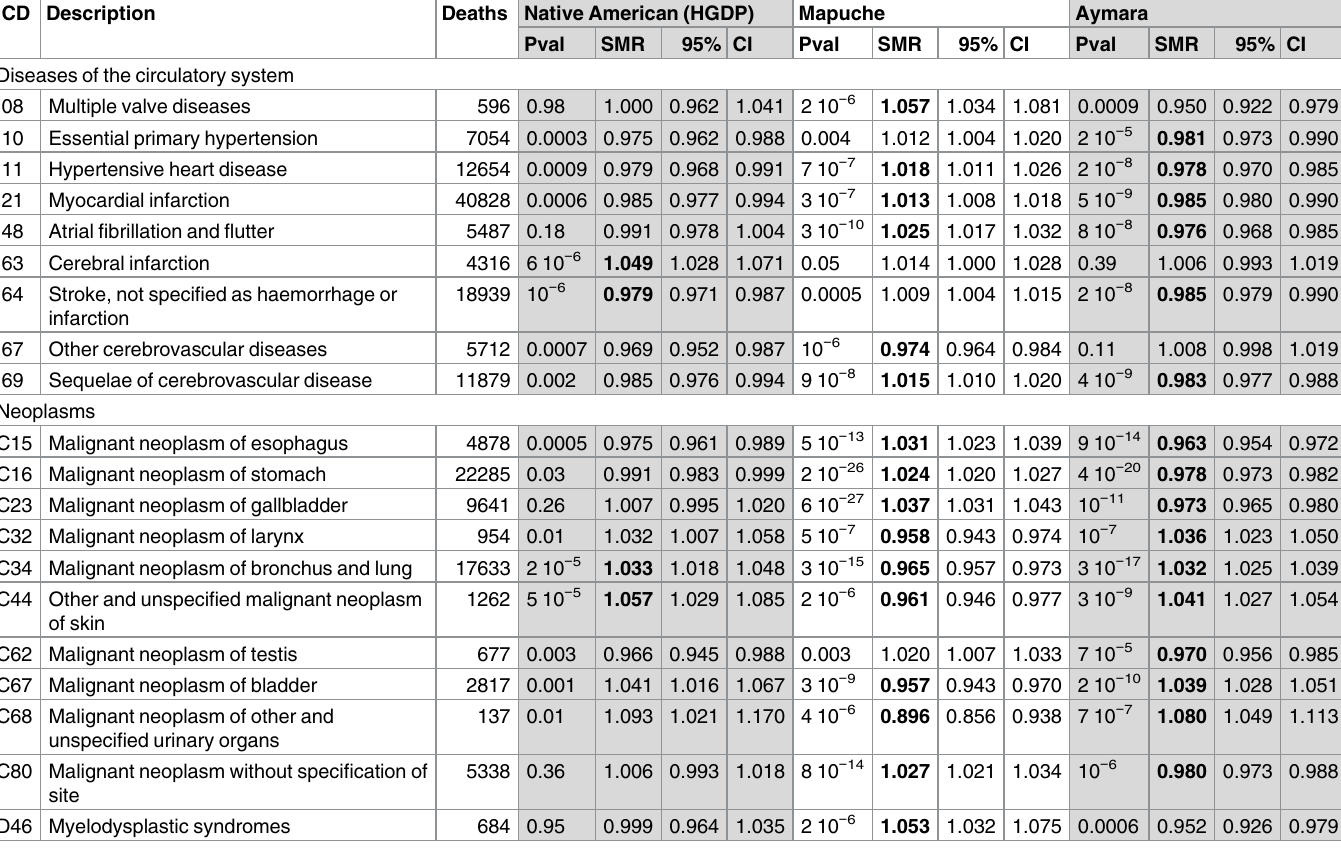
Table 2. Total number of deaths and standardized mortality ratios (SMR) due to diseasesof the circulatory systemand to neoplasms by 1% increasein the Native American (HGDP), Mapuche and Aymara